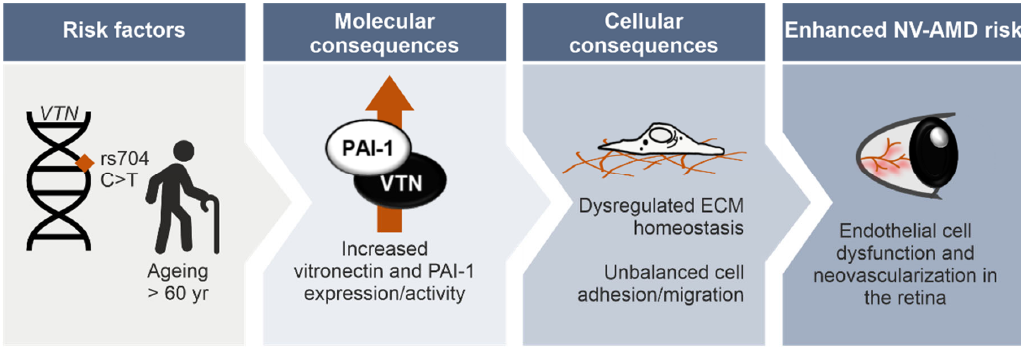
Figure 6. Conceptual disease model of rs704 ‐ associated pathobiology leading to NV ‐ AMD.